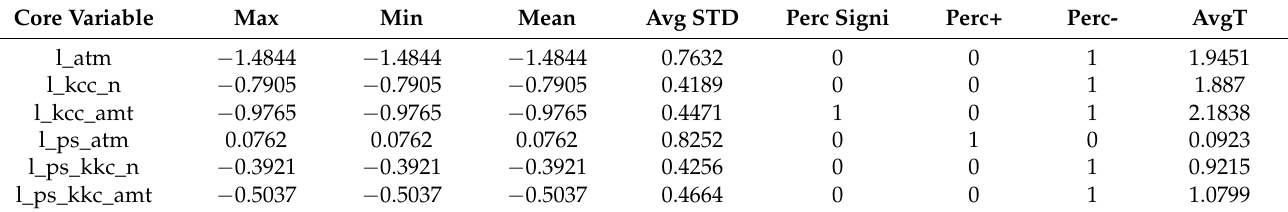
Table 7. Robustness of the results.